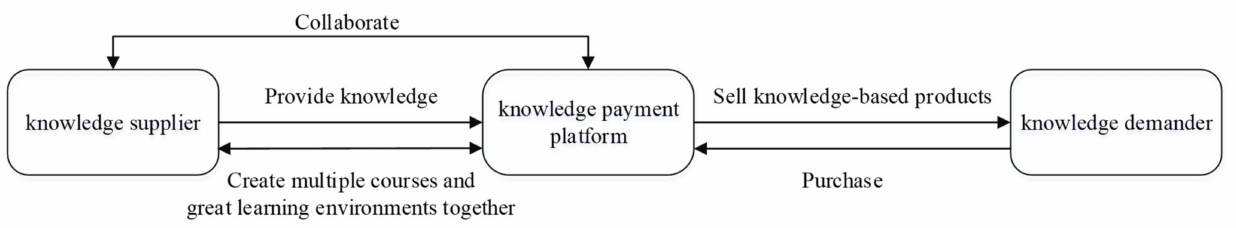
Figure 1. The business model of the online knowledge